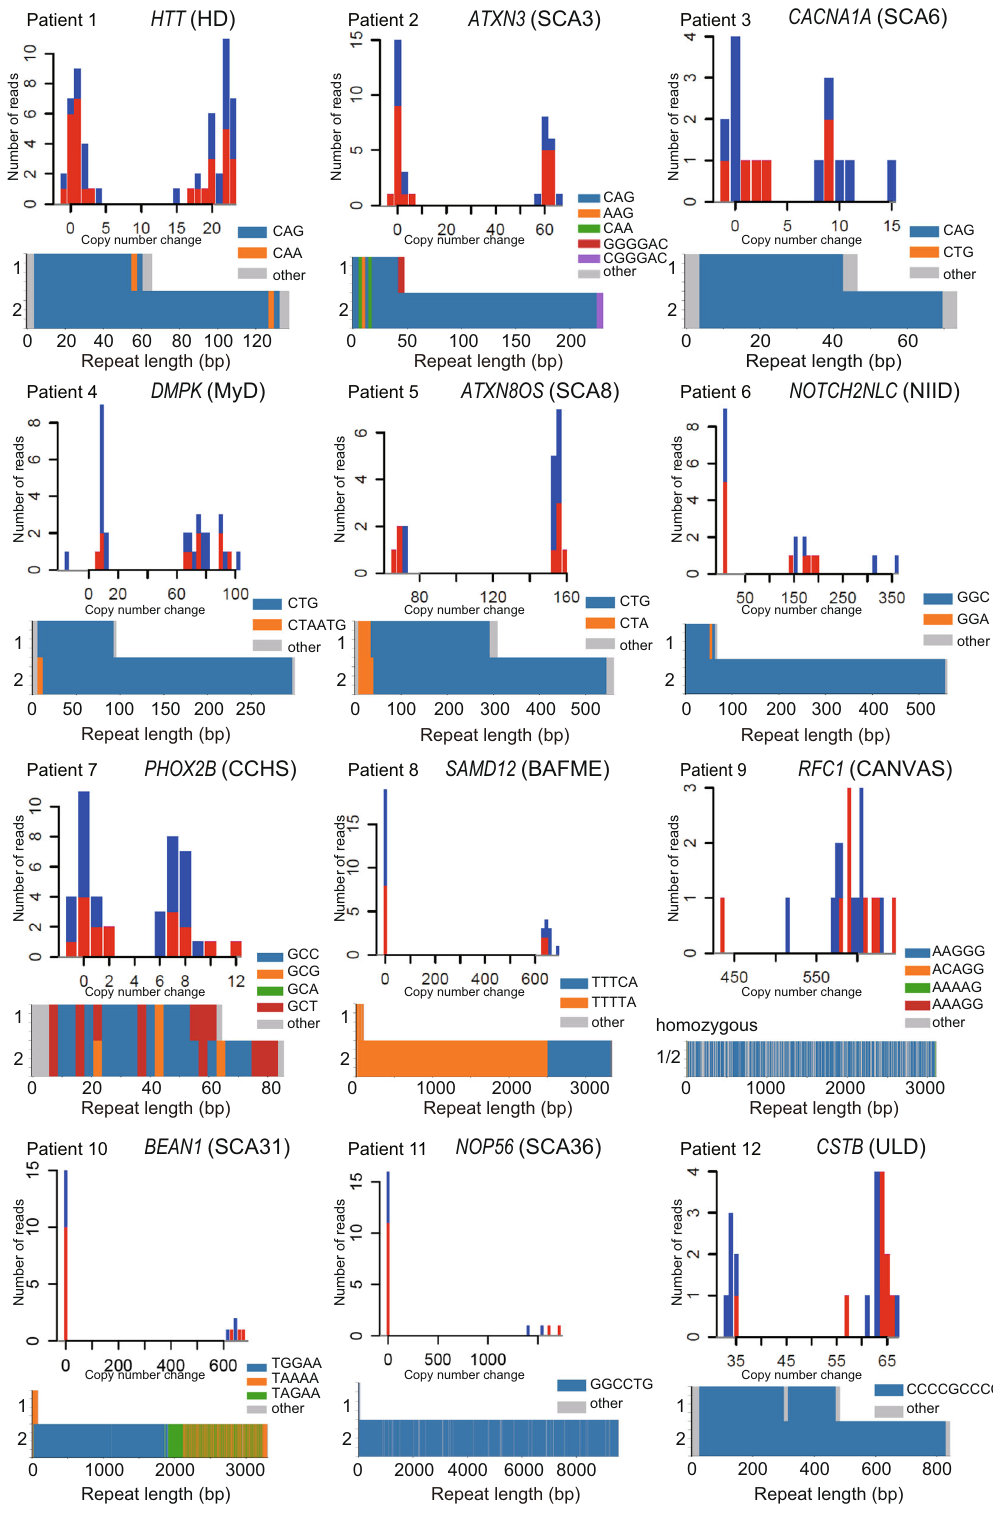
Fig. 2 Pathogenic repeat expansions identi fi ed in all positive control samples. Histograms of tandem-genotypes output and waterfall plots for all positive controls in the validation study are shown. For the histograms, the X-axis indicates copy number change compared with the number of repeat units in the reference human genome: 21 for HTT , 10 for ATXN3 , 13 for CACNA1A , 20 for DMPK , 15 for ATXN8OS , 13 for NOTCH2NLC , 20 for PHOX2B , 20 for SAMD12 , 11 for RFC1 , 13 for BEAN1 , 4 for NOP56 , and 3 for CSTB . The waterfall plot was generated using either hac mode (Patients 1, 2, 3, 7, 8, 9) or sup mode (Patients 4, 5, 6, 10, 11,